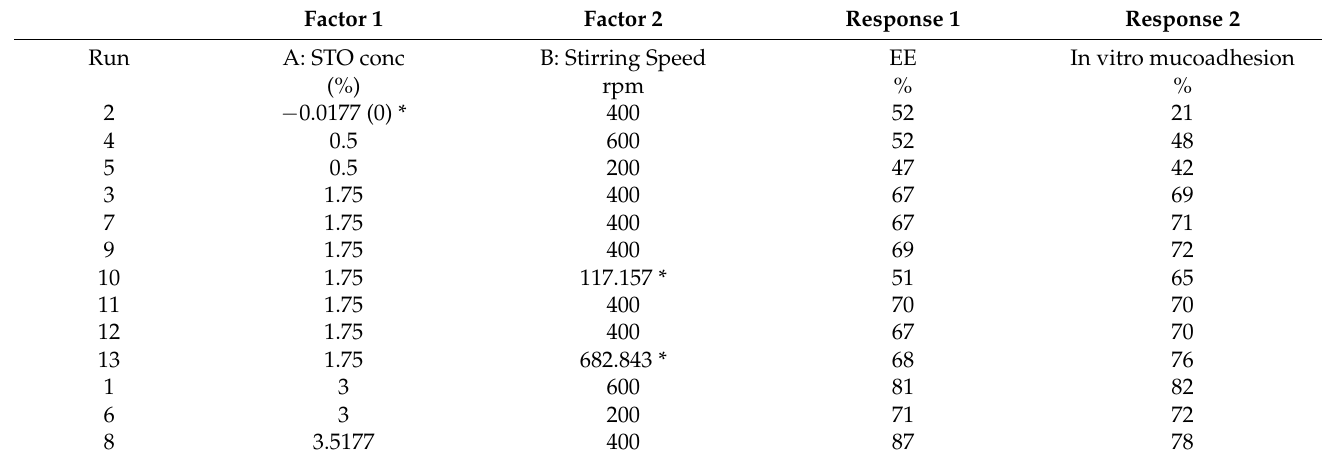
Table 3. Projected trial batches and their responses for central composite